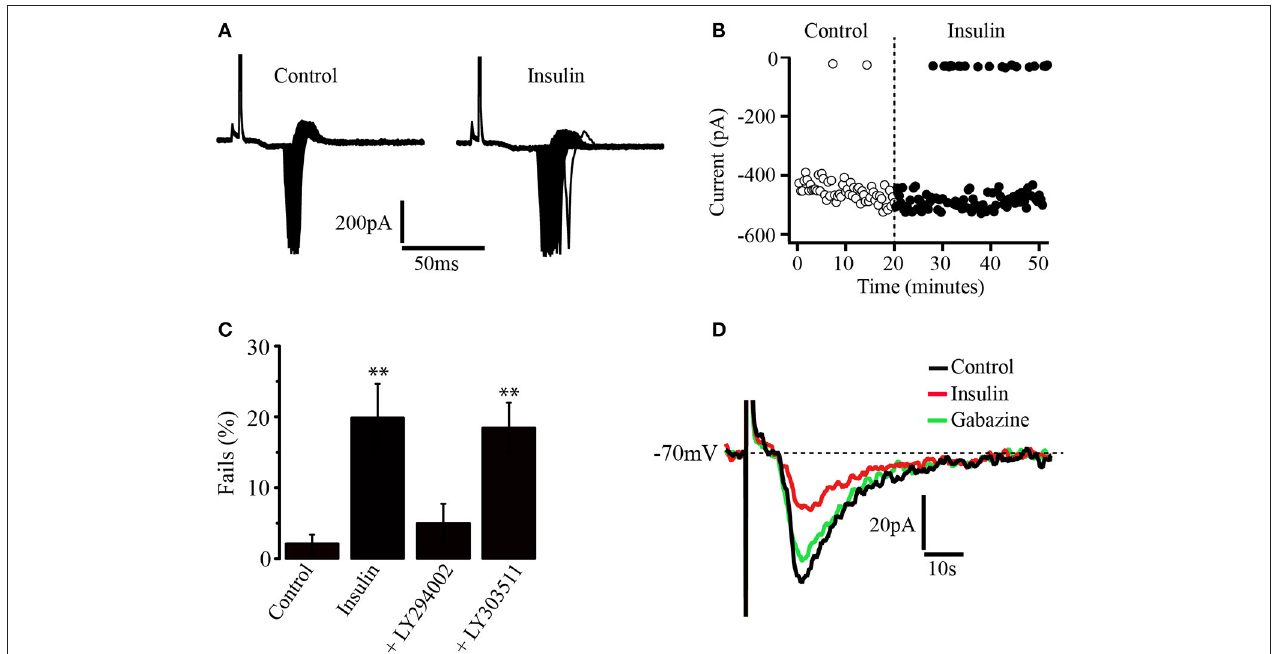
FIGURE 6 | Insulin decreases the gain of pyramidal PFC neurons. (A) Recordings of action currents in cell-attached configuration in the absence (left) or the presence (right) of insulin (500nM). Note the variability of the latency induced by insulin. (B) Insulin increases the number of fails in generating action currents (black dots) as compared with control (white dots). (C) Bar graphs show the fails percentages in control ( n = 6), insulin ( n = 6), the PI3K inhibitor LY294002 ( n = 5), and the inactive analog LY303511 ( n = 6). Only insulin and insulin plus LY303511 were statistically different from control. (D) Insulin (red line) decreases the amplitude of evoked synaptic currents and the effect is reversed by gabazine (green line) in perforated patch configuration ( n = 5) ** p < 0.01.